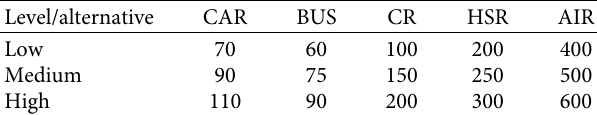
Table 1: Average speeds (kph) of the alternatives per level. Level/alternative